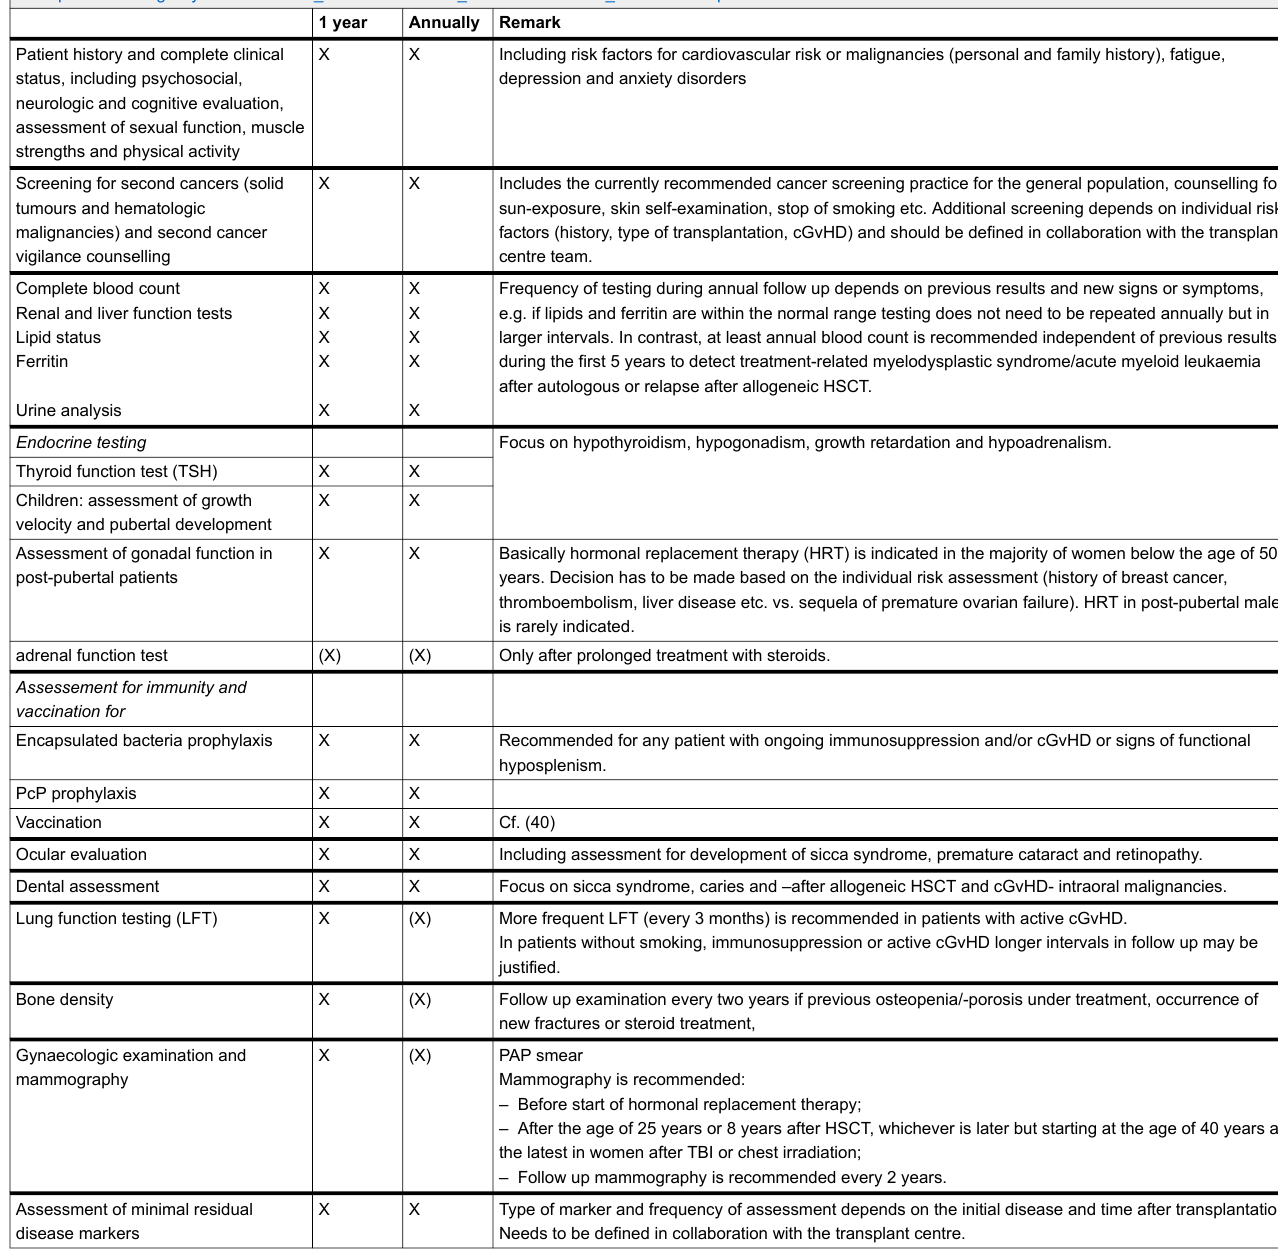
Table 2: Checklist to follow HSCT patients at 1 year post-transplant and annually thereafter. Additional testing may be required depending on the individual status of the patients. A helpful summary of recommendations for post-transplant follow up can be accessed at: